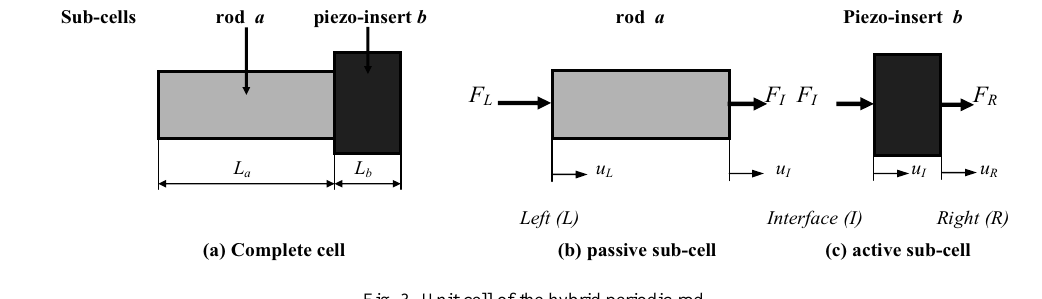
Fig. 3. Unit cell of the hybrid periodic